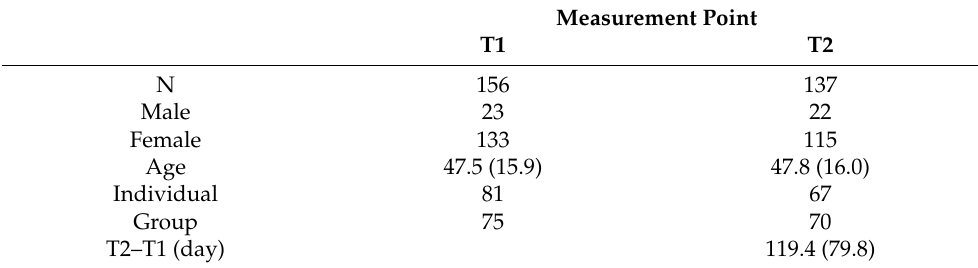
Table 2. Descriptive characteristics of the outcome-monitoring study’s sample.